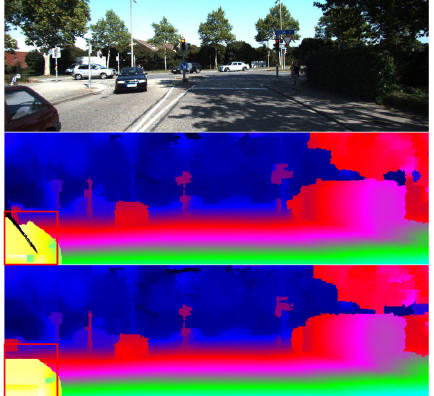
Figure 3. The original disparity map and the improved disparity map (a).